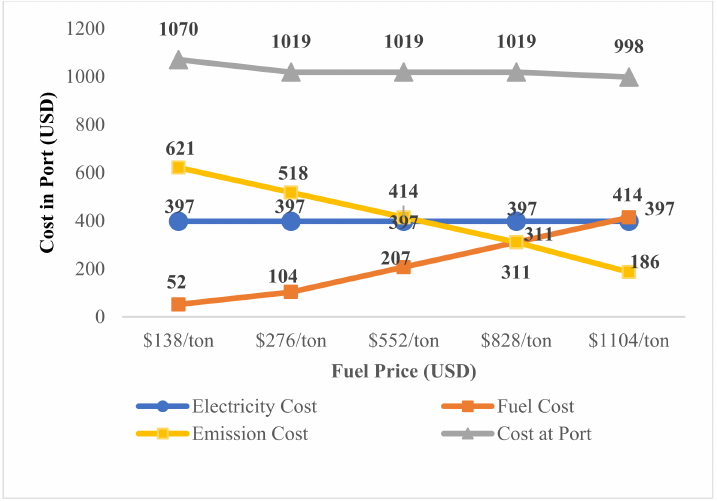
Figure 5. Cost analysis under different fuel types considering pollution gas